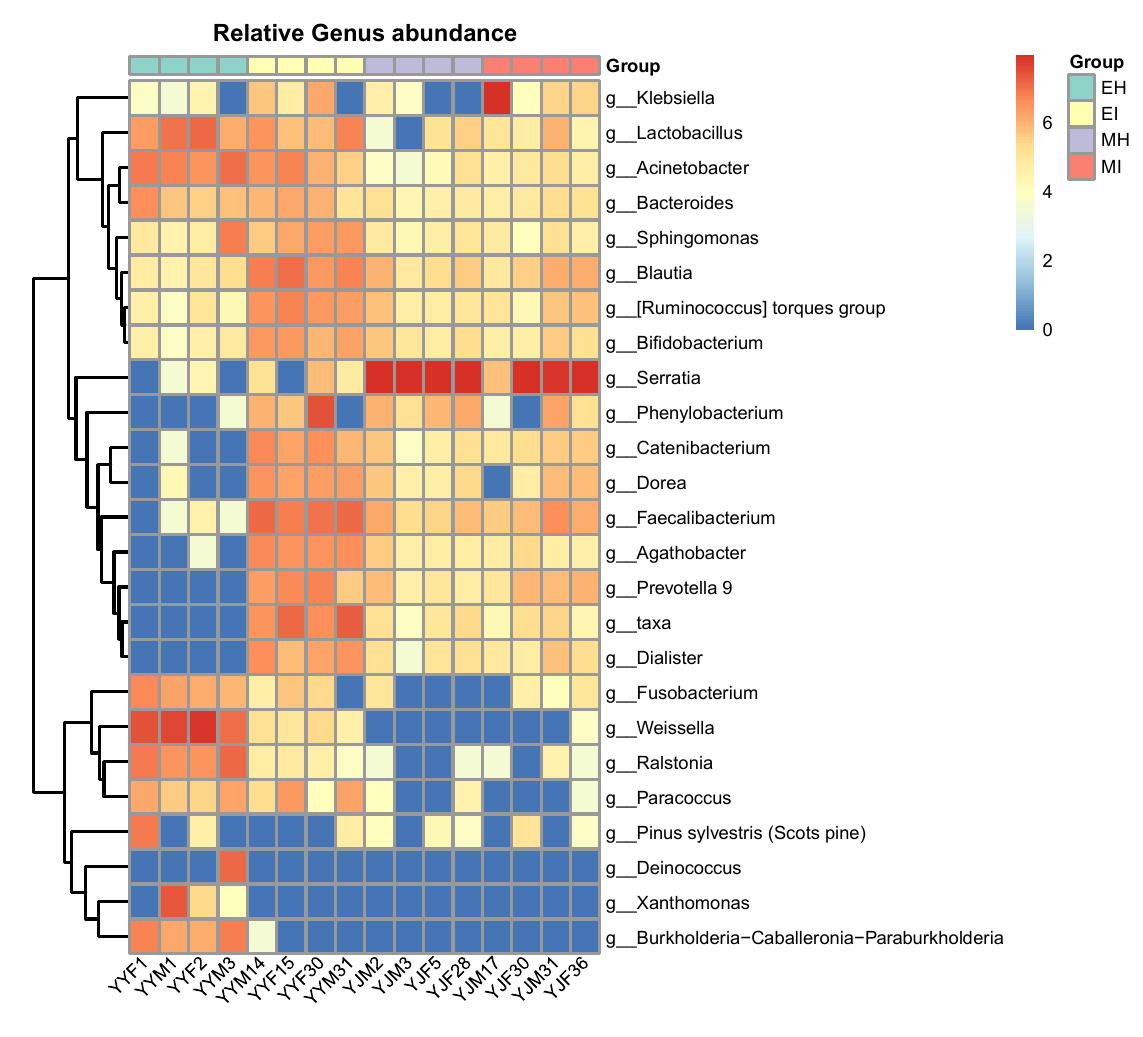
Figure 6. Heatmap showing the relative abundance of dominant taxa in each group. Cluster analysis used the Bray-Curtis distance and complete-linkage method. Each bar or column corresponds to a group (three individuals per species). (EH: emergence period, healthy; EI: emergence period, infested; MH: mating period, healthy; MI: mating period, infested).